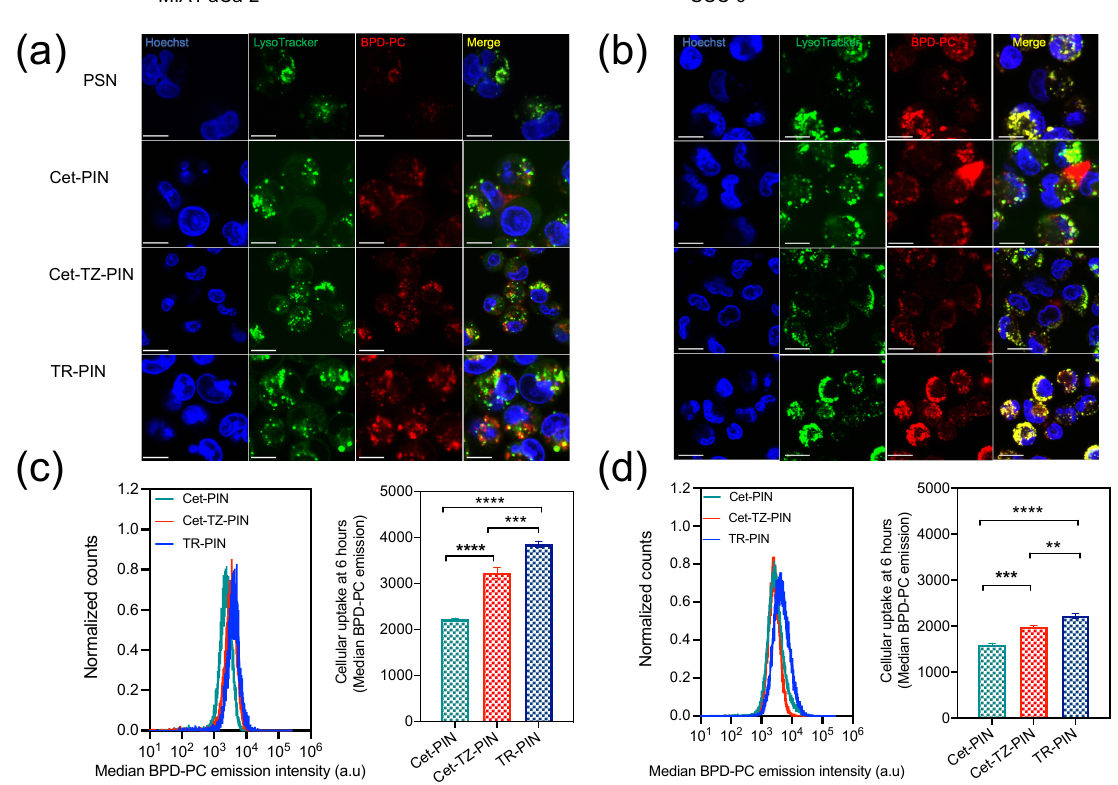
Figure 5. Triple-receptor targeting enhances TR-PIN cellular uptake to MIA PaCa-2 and SCC-9 cells. Confocal images (60X) demonstrate intracellular uptake of Cet-targeted PINs (Cet-PINs), Cet- and TZ-targeted PINs (Cet-TZ-PINs), and triple-receptor-targeted PINs (TR-PINs) in MIA PaCa-2 ( a ) and SCC-9 ( b ) cells after 6 h of incubation. PINs localize to lysosomal compartments as shown in the merged channel images where yellow indicates co-localization of BPD-PC (red) and lysosomes (green). The nuclei, lysosomes, and BPD-PC were visualized using 405 (Hoechst and BPD-PC) and 559 nm (LysoTracker) laser excitation. Scale bar = 50 µ m. Flow cytometry quantitation of cellular uptake of PINs (median BPD-PC emission signals) is shown for (c) MIA Paca-2 and ( d ) SCC-9 cells at 6 h incubation. (mean ± S.E.M.; n = 6–9 for c–d; one-way ANOVA with a Tukey post-test; **** = p ≤